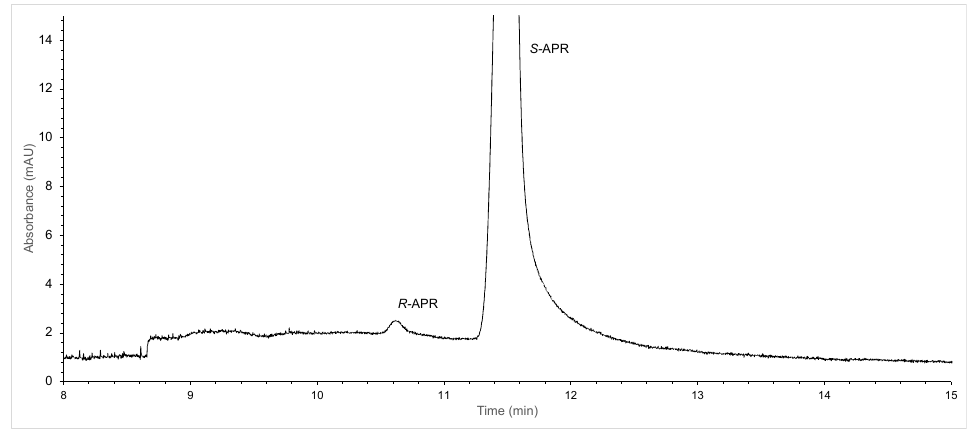
Figure 5. Electropherogram obtained using the optimized parameters for the determination of 0.1% R -APR in an S -APR sample. CE conditions: PB-coated capillary; BGE: 50 mM phosphate buffer (pH 7.0), supplemented with 25 mM Succ- β -CD with the indicated DS; capillary temperature: 20 ◦ C; hydrodynamic injection: 50 mbar × 4 s; detection: 230 nm and − 18 kV (reverse polarity). Sample concentrations: 2 µ g/mL R -APR and 2000 µ g/mL S